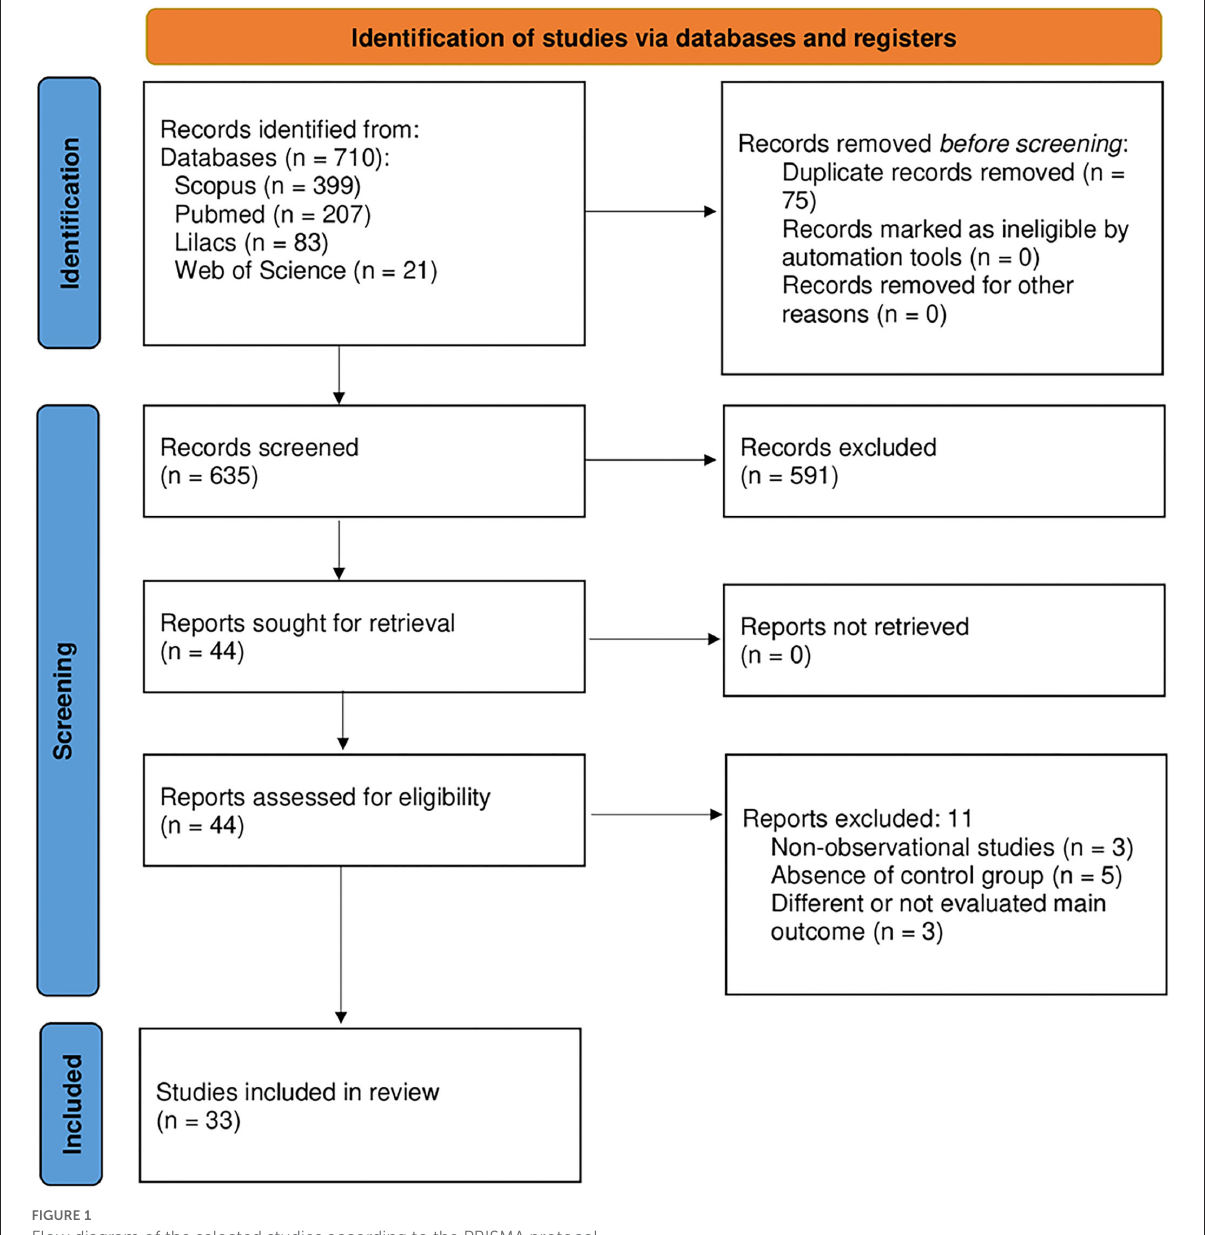
FIGURE1 Flow diagram of the selected studies according to the PRISMA